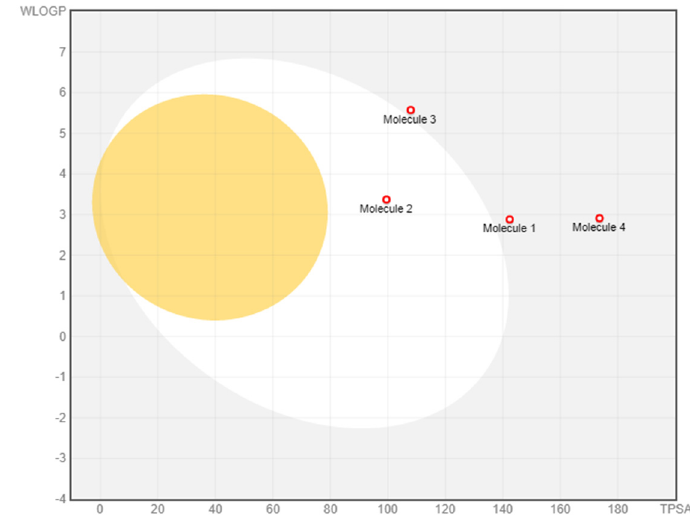
Figure 4. BOILED-Egg plot. Points located in the BOILED-Egg’s yellow are the compounds predicted to permeate the BBB passively. Conversely, the ones in the white are the molecules predicted to be only passively absorbed by the gastrointestinal tract. Legend: 6g -molecule 1; 13g -molecule 2; 13e -molecule 3; 6f -molecule 4. Table 4. pkCSM calculated absorption properties.